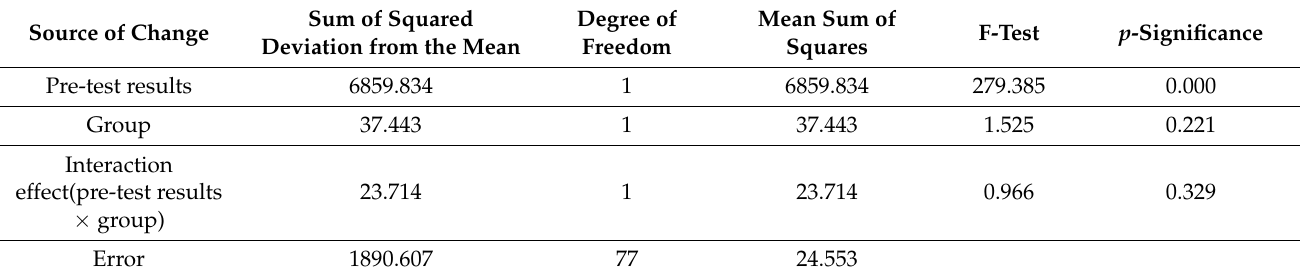
Table 8. Test of homogeneity of within-group regression coefficients.